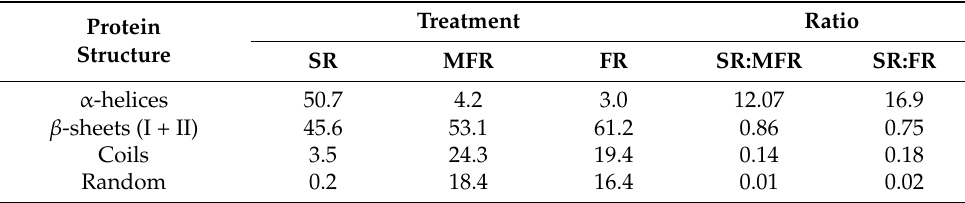
Table 3. Secondary protein structures (expressed as %) of the root samples derived from each treat- ment (SR, the non-treated seed; MFR, the seeds surrounded by S. mycoparasitica against F. graminearum ; FR, the seed infected by F. graminearum